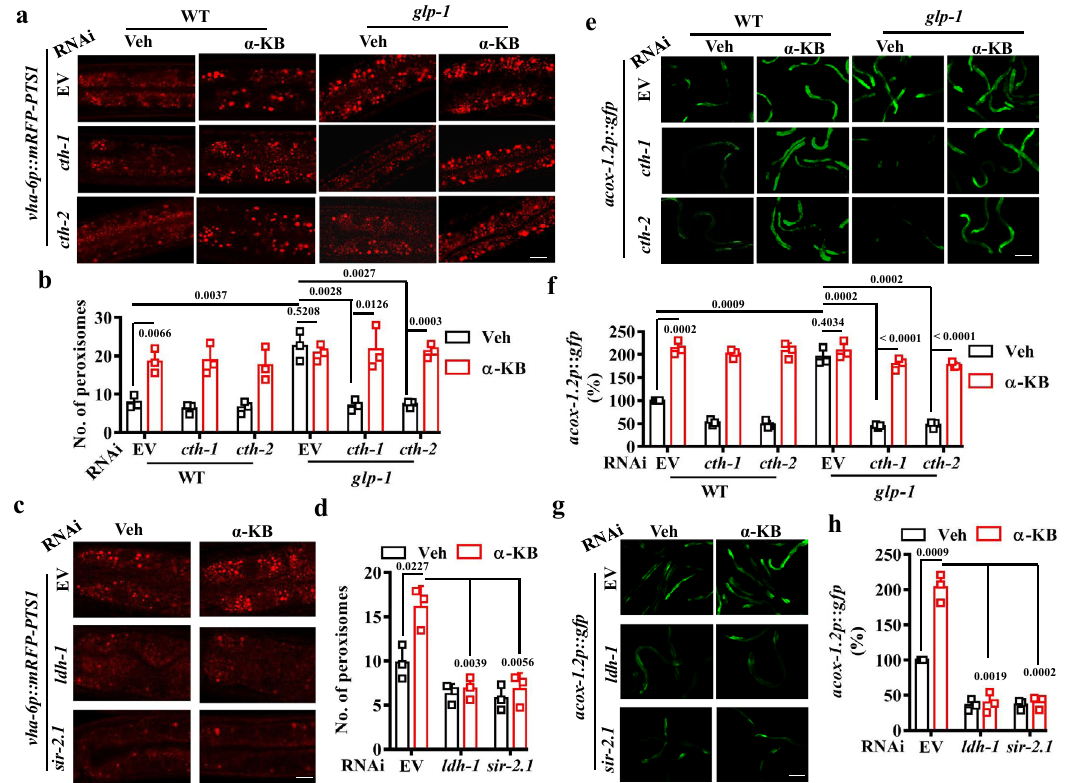
Fig. 3 | Alpha-KB promotes peroxisome function and biogenesis via the NAD + -SIR-2.1 pathway. a Representative images of peroxisomes in glp-1 ( e2141ts ) mutantwormsexpressing vha-6p::mRFP-PTS1 .Scalebars:2.5 μ m.Vehvehicle. b The number of peroxisomes was increased in glp-1 ( e2141ts ) mutants. RNAi knockdown of either cth-1 or cth-2 inhibited this increase, which was rescued by supple- mentation with α -ketobutyrate ( α -KB, 500 μ M). Data were presented as mean values±SEM of three independent experiments ( n =25 worms per experiment). c Representative images of peroxisomes in transgenic worms expressing vha- 6p::mRFP-PTS1 after treatment with α -KB. d Supplementation with α -KB (500 μ M) increased the number of peroxisomes in worms, which was inhibited by RNAi knockdown of either ldh-1 or sir-2.1 . Data were presented as mean values±SEM of three independent experiments ( n =25 worms per experiment). e Representative